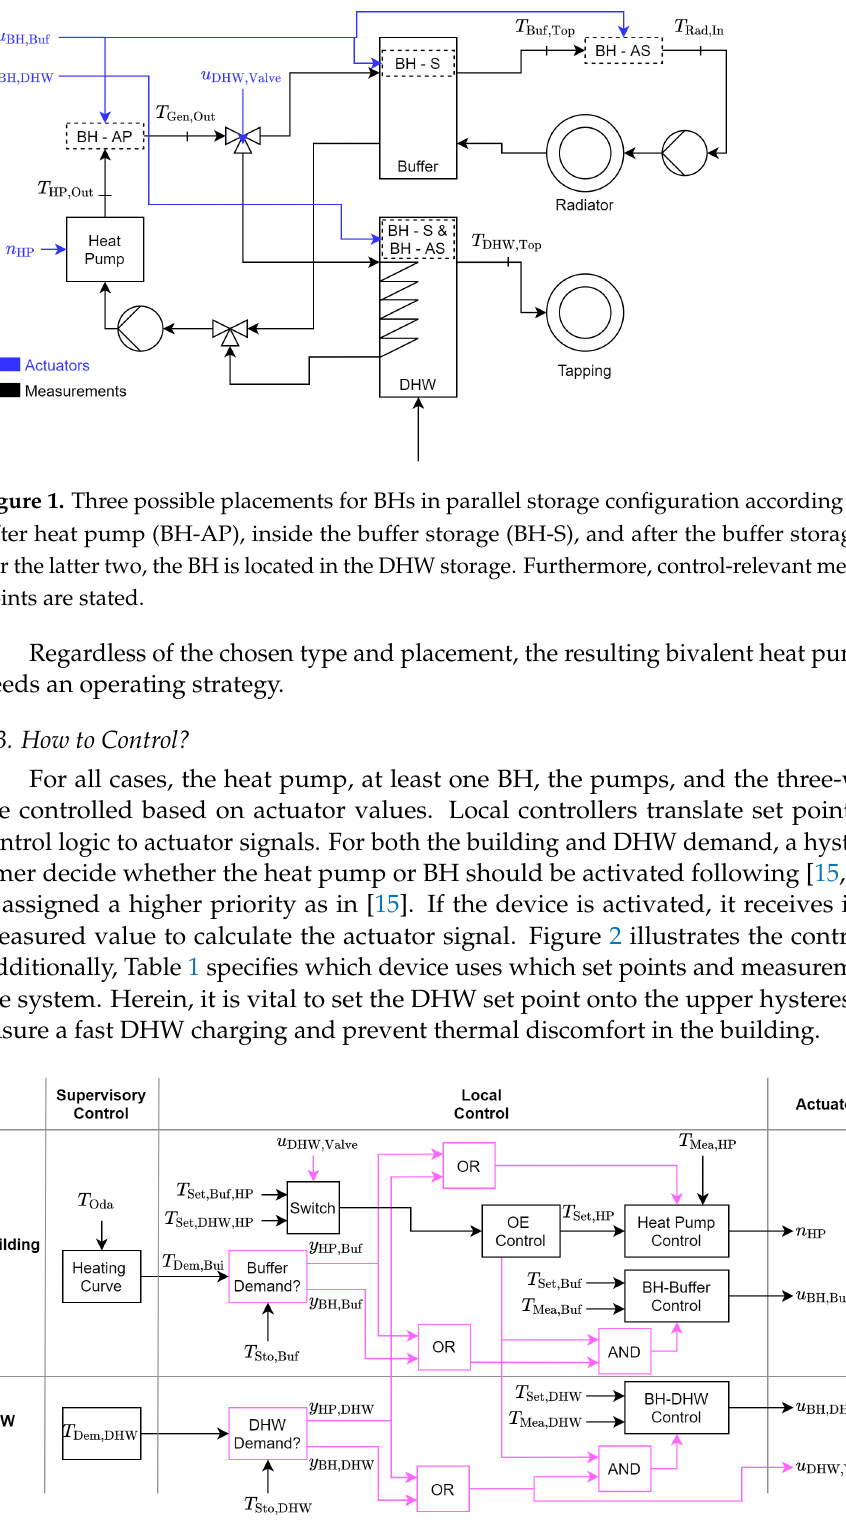
Figure 2. This rule-based control logic ensures that the system meets the building and DHW